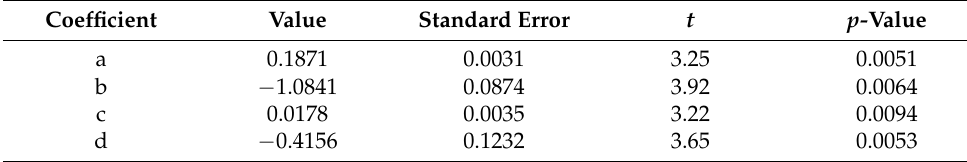
Figure 4. ( a ) β θ vs. SR model calibrated from field data (radians values); ( b ) β α vs. SR model calibrated from field data. Grey bounds are the 95% confidence intervals, red lines are the cali- brated models. Table 4. Hypsometer accuracy models coefficients (Equations (4) and